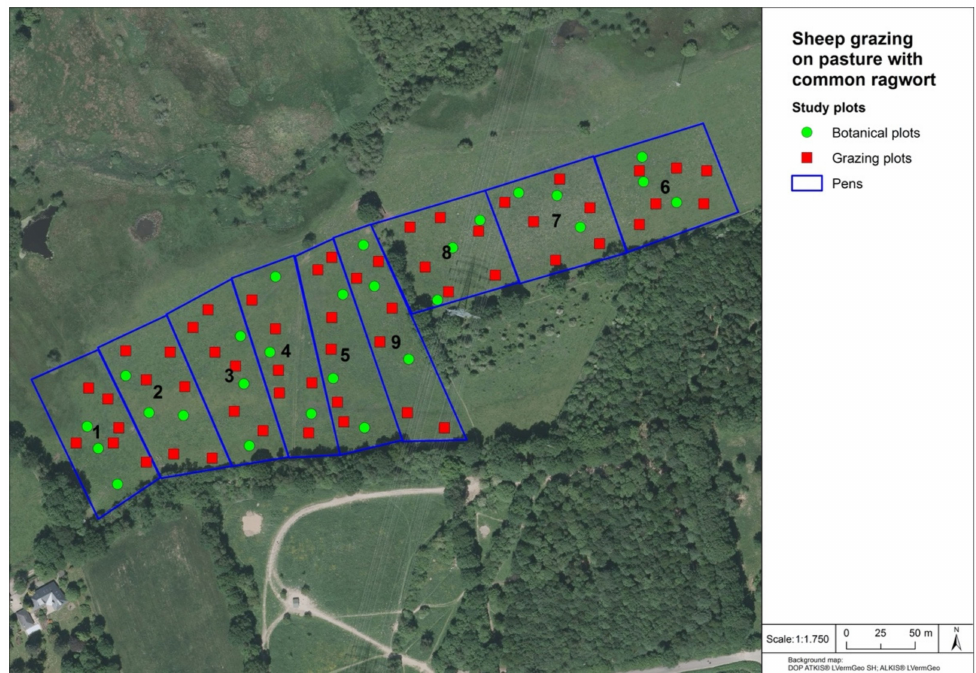
Figure 1. Schematic classification of the nine pens (blue lines, numbers 1 to 9), 54 grazing plots (red markers), and 27 botanical plots (green markers). (Background map: DOP ATKIS ® LVermGeo SH; ALKIS ®